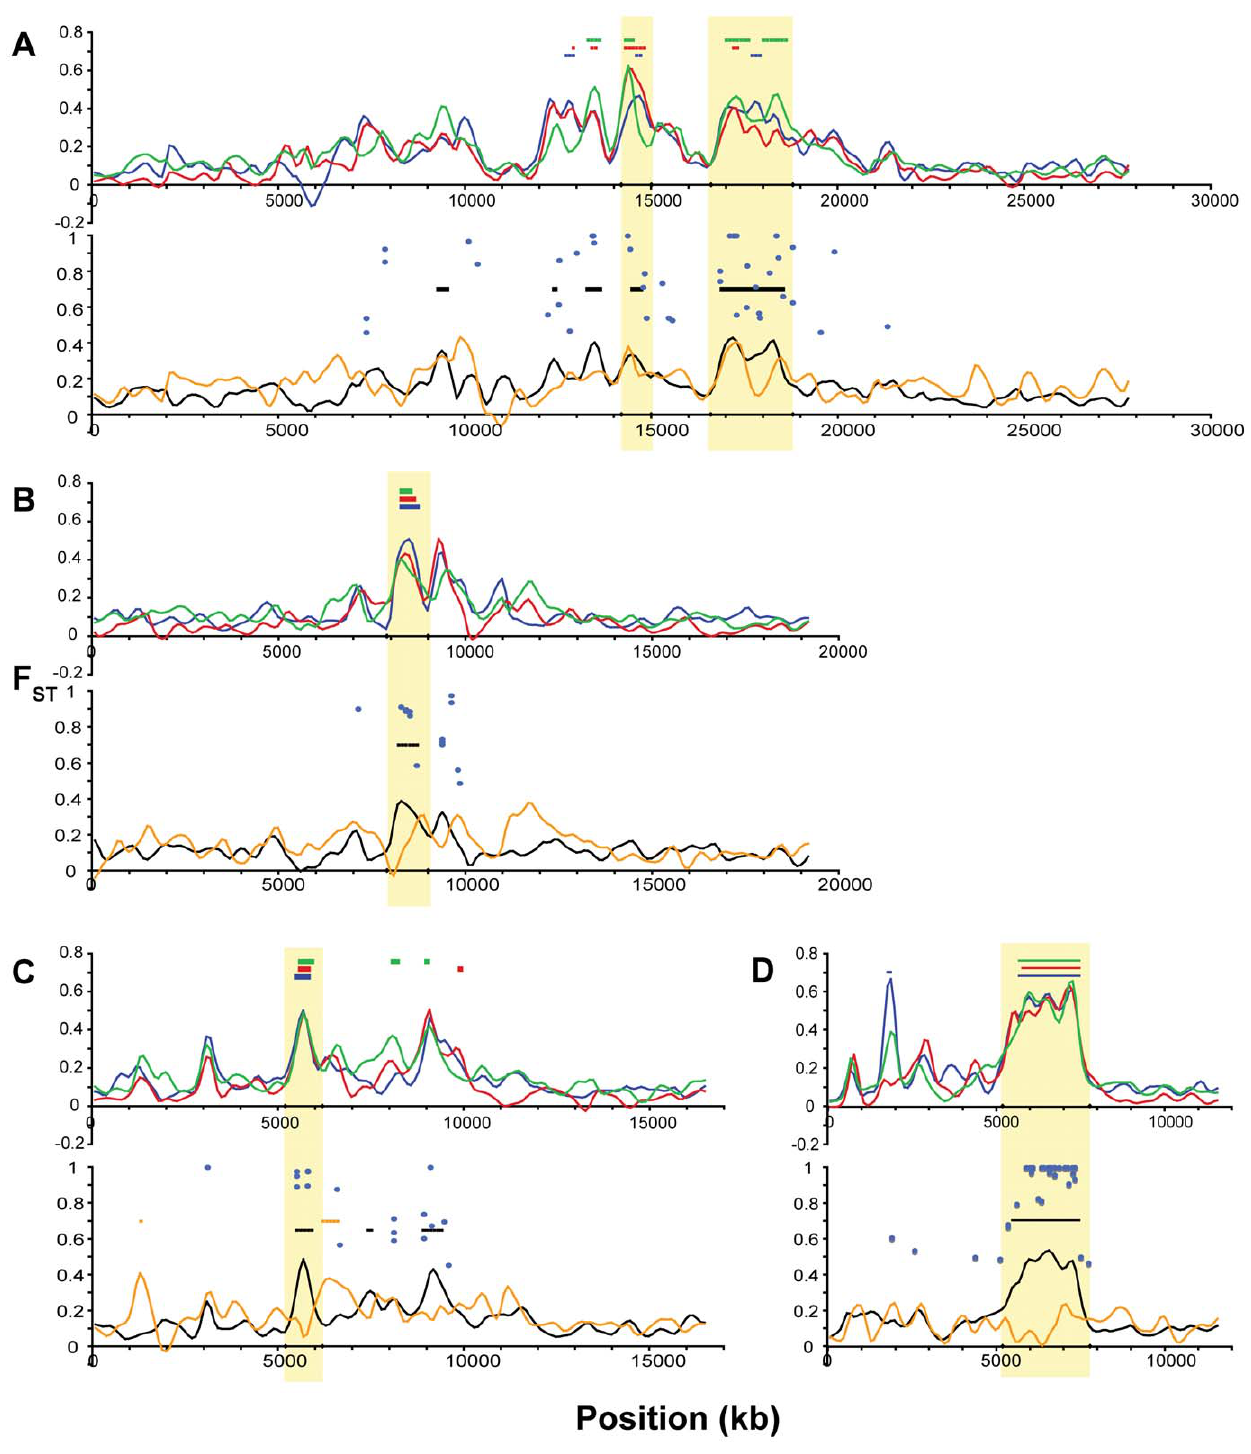
Figure 8. Differentiation among oceanic and freshwater populations on Linkage Groups VII, VIII, XI, and XXI. All panels show population differentiation as in Figure 7. (A) LG VII. (B) LG VIII. (C) LG XI. (D) LG XXI. Exceptions to the pattern described above are found at the F ST addition, p is elevated in oceanic populations at the LG I region peaks on LG I and XI. Here, the private allele density in (Figure S1A, S1B, S1C). These data suggest the hypothesis that the freshwater does not differ significantly from the genome-wide oceanic environment may be permissive for multiple haplotypes at average (Figure 9B–9D), but private allele density in the ocean these genomic regions, of which only a subset have relatively high relative to freshwater is significantly higher (Figure S2B). In fitness in freshwater. In contrast, in the region centered at 13.3 Mb